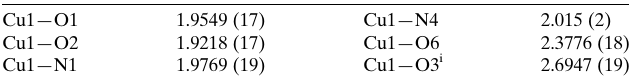
Table 1 Selected bond lengths (A˚ ).